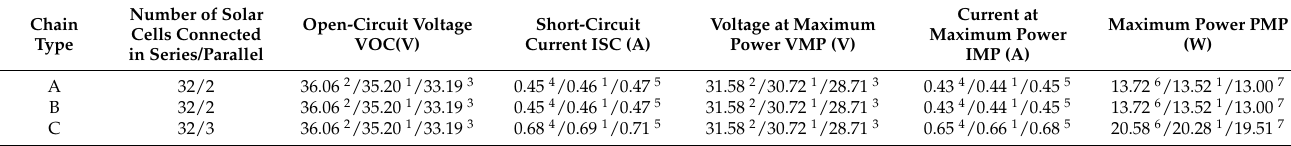
Table 1. Technical specifications for the used solar